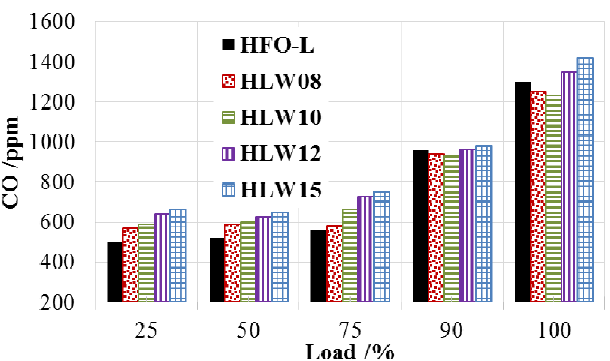
Energies 2015 , 8 , page–page